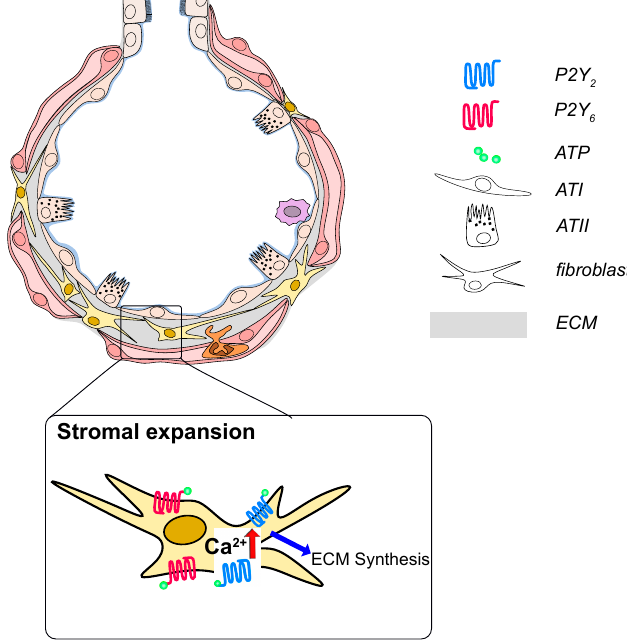
Figure 3. P2 receptor signaling in development and progression of idiopathic pulmonary fibrosis (IPF) ATP and UTP are released from injured epithelial cells and are increase in the BAL fluid from IPF patients. Activation of P2Y 2 or P2Y 6 on fibroblasts results in fibroblast proliferation, migration and likely excessive deposition of extracellular matrix constituents.